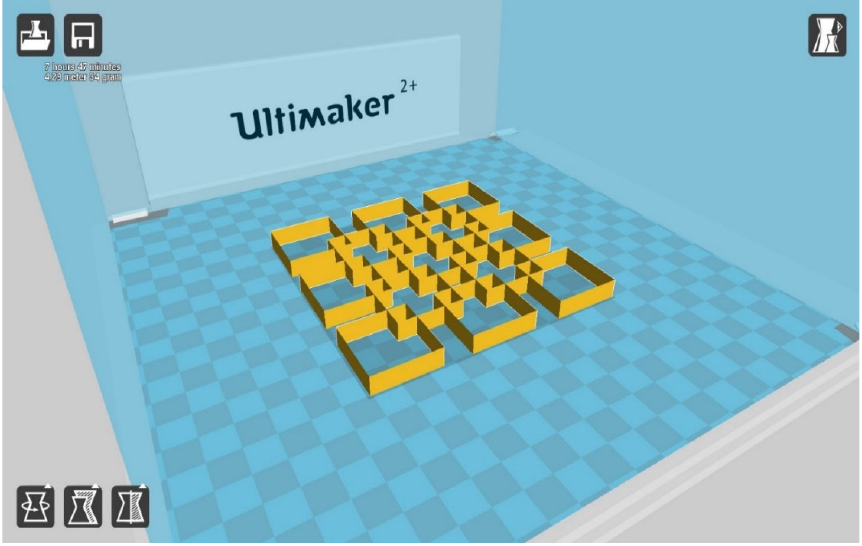
Figure 2. The 3D concrete component slice model in